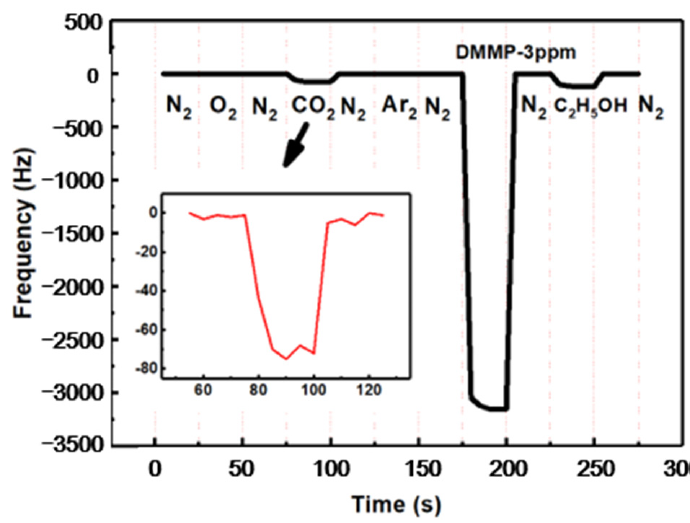
Figure 10. Selectivity of the SAW DMMP sensor.